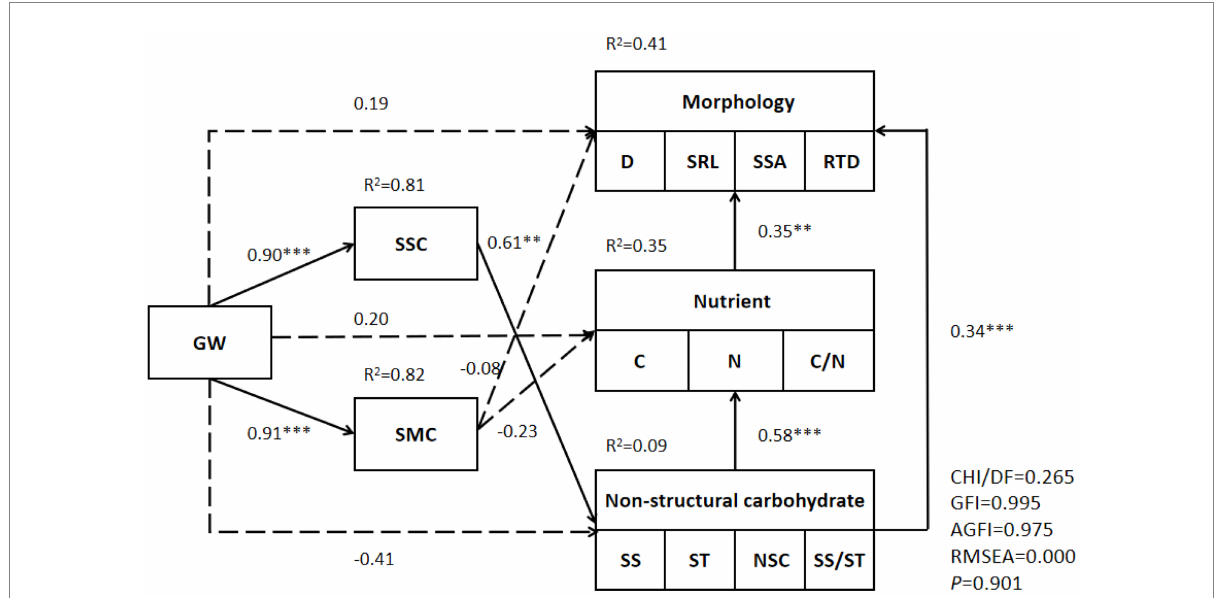
FIGURE 6 Structural equation model of Tamarix chinensis fine root characteristics and environmental factors. ** significant at 0.01 level and *** significant at 0.001